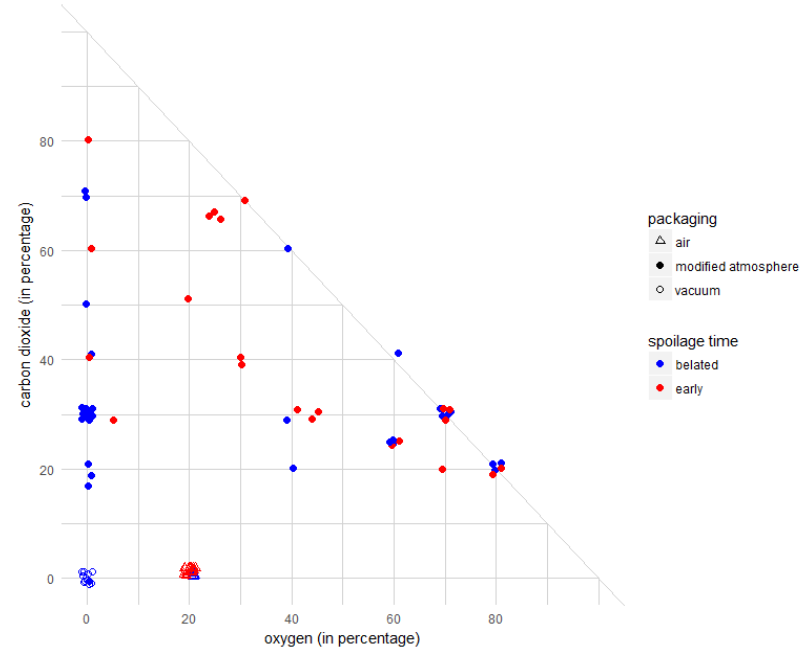
Figure 5. MAP triangular graph depicting the spoilage stage following different initial proportions of O 2 and carbon dioxide in the packaging. The data are represented as jitter points to avoid overplotting. The blue and red symbols correspond to belated and early spoilage, respectively. The shapes of the points correspond to different types of packaging.